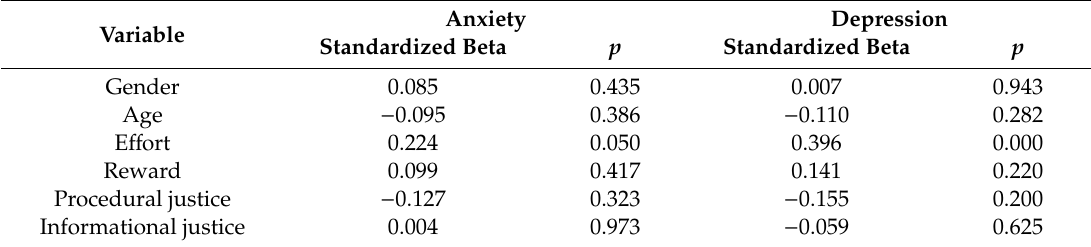
Table 4. Linear regression analysis. Relationship between demographic factors, stress, justice, and mental health